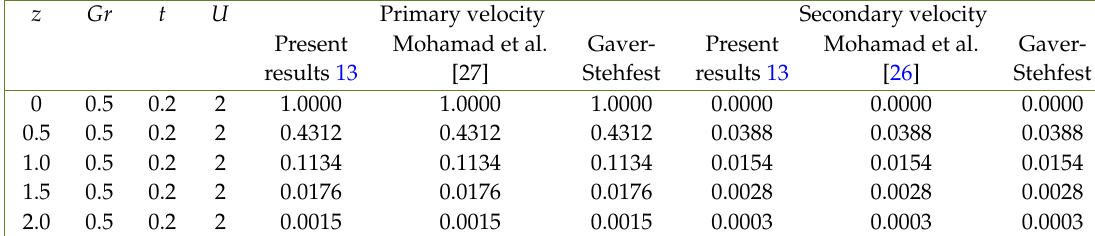
Table 6. Comparison of velocity solutions 13 ( φ =0) with Mohamad et al. [26] ( ω =0) and Gaver–Stehfest algorithm.